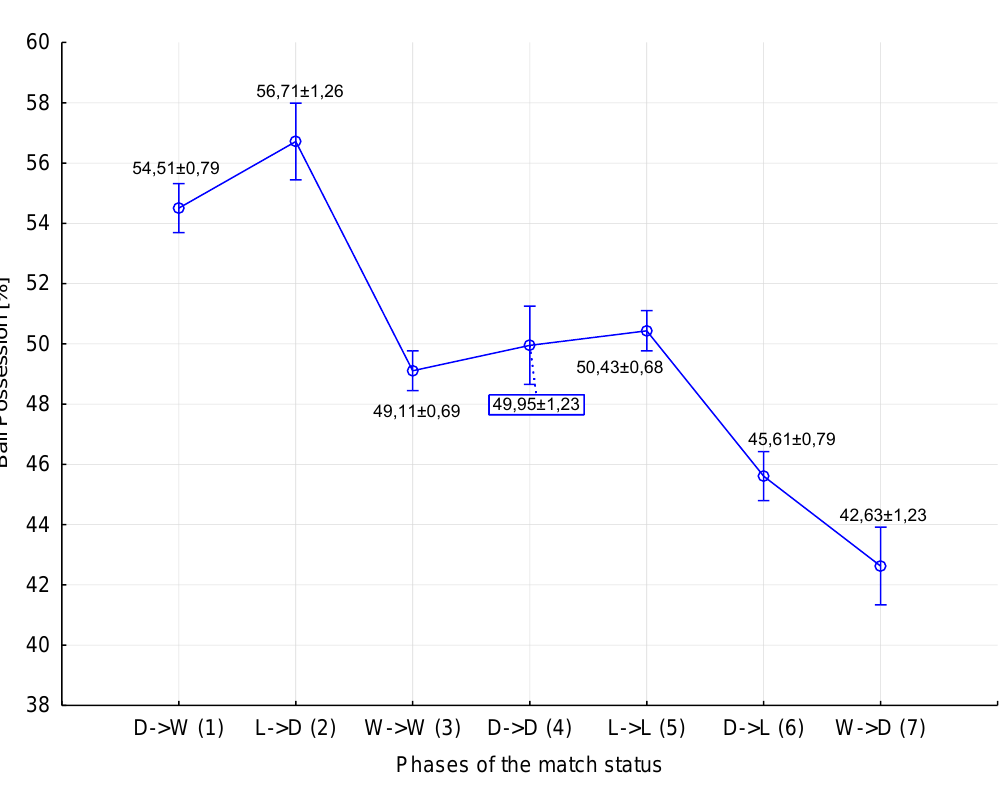
Figure 1. Differences in ball possession achieved by soccer players with regard to match-status phases (mean ± SE). Statistically significant differences: 1,2,3,4,5 > 7; 1,2,5 > 6; 1 > 3,6,7; 2 > 3,4,5,6,7.